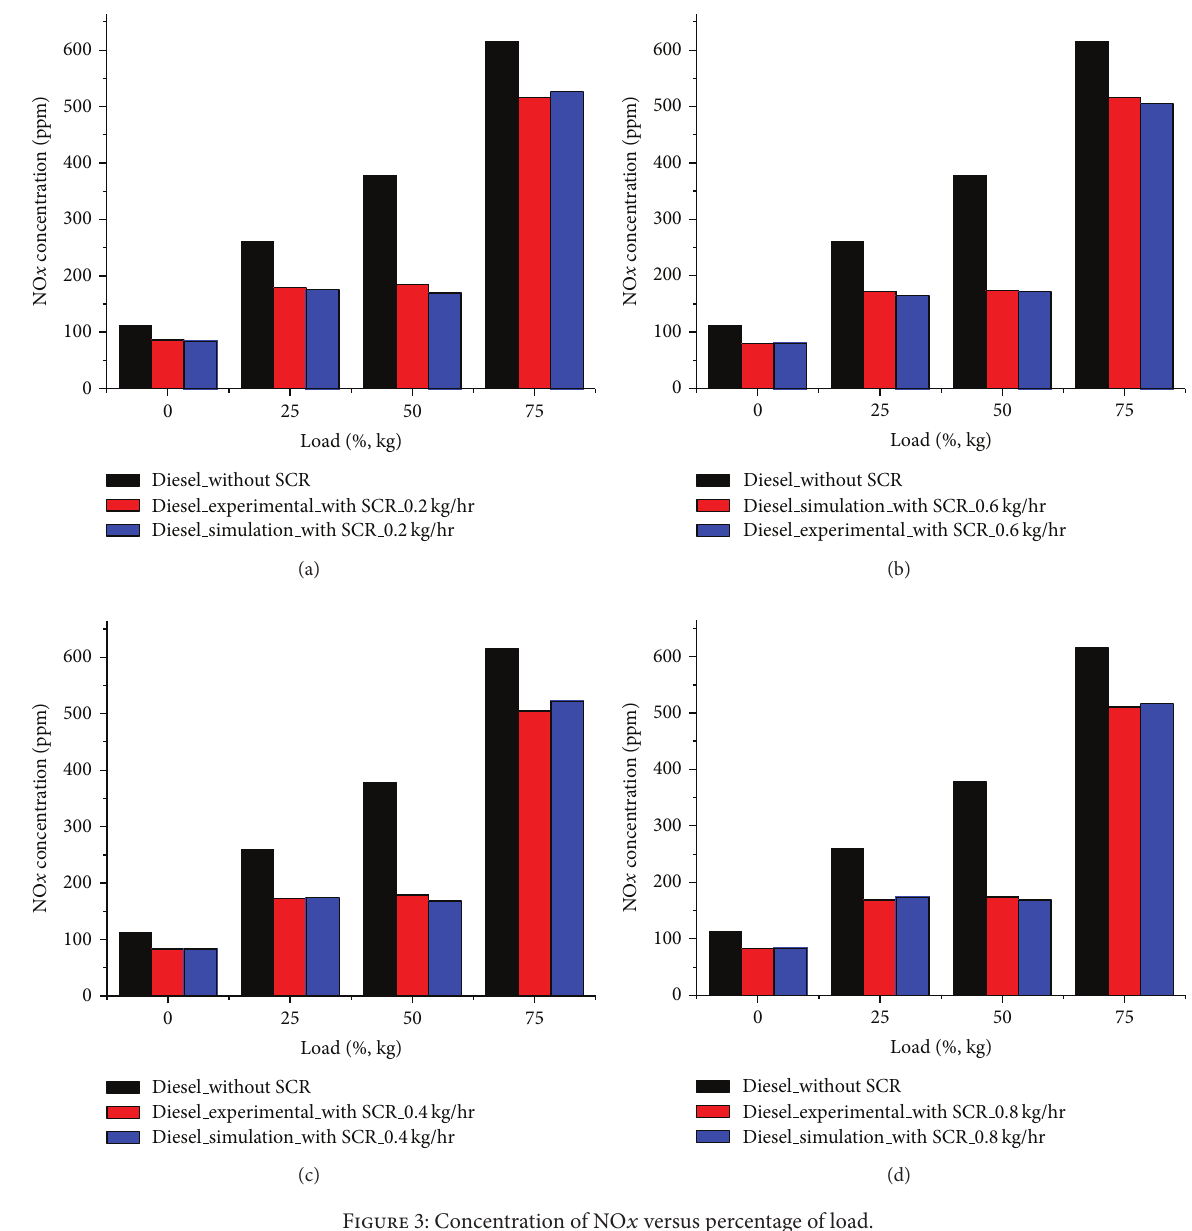
Figure 3: Concentration of NO 𝑥 versus percentage of